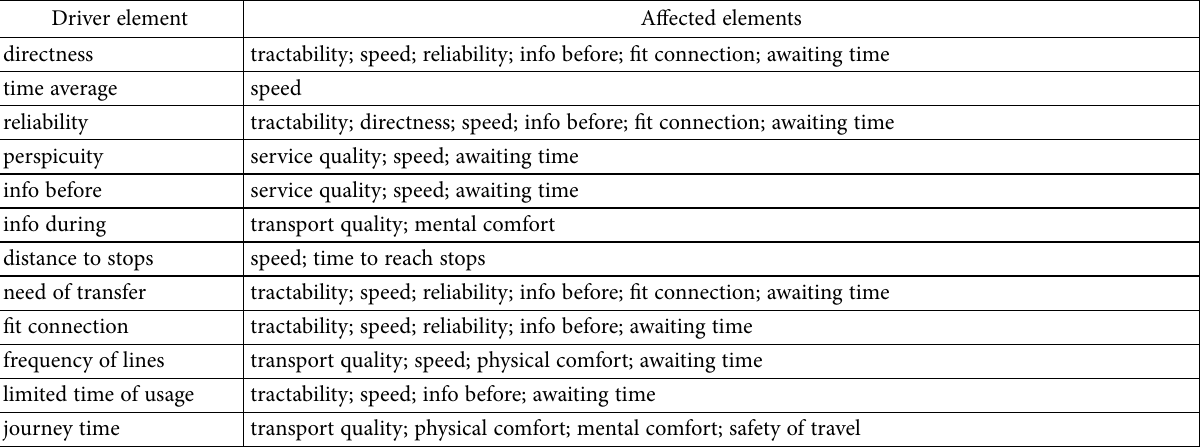
Table 2. Interrelations of the factors based on ISM results (source: research by author) Driver element